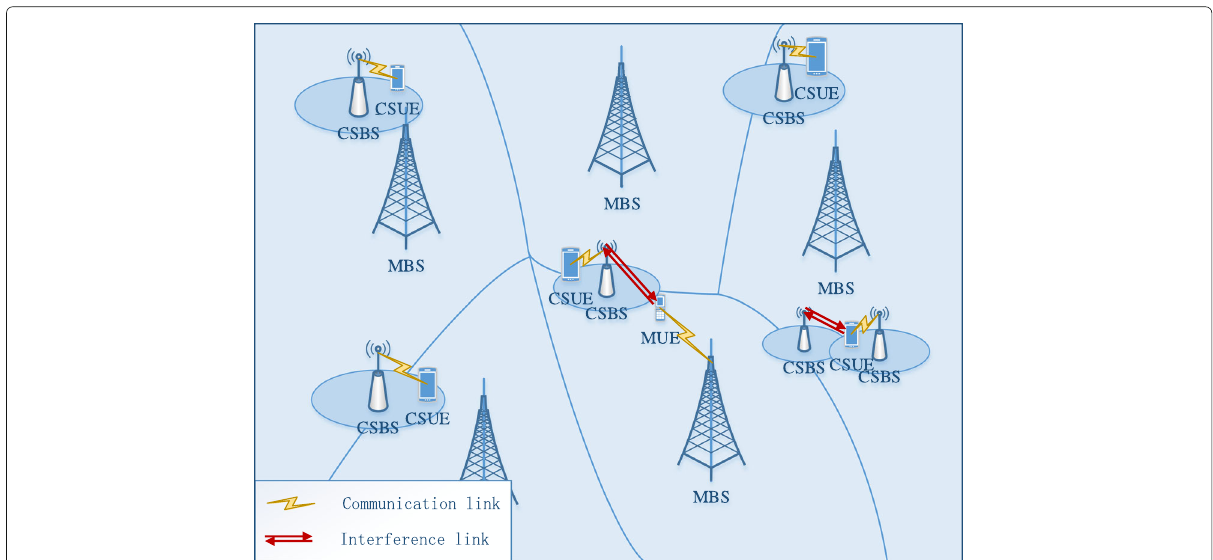
Fig. 1 A two-tier network